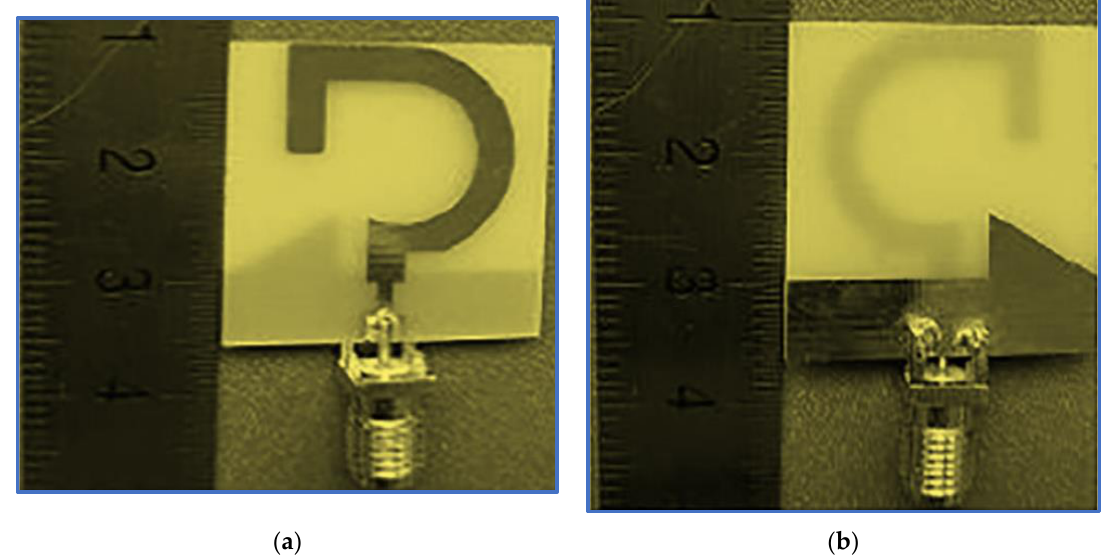
Figure 28. A prototype of the modified inverted C-shaped monopole antenna: ( a ) front view; ( b ) back view [141].